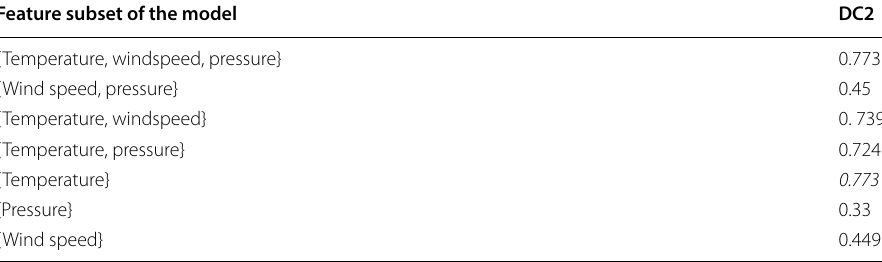
Table 3 R-squared result for subsequent models in DC2 Feature subset of the model